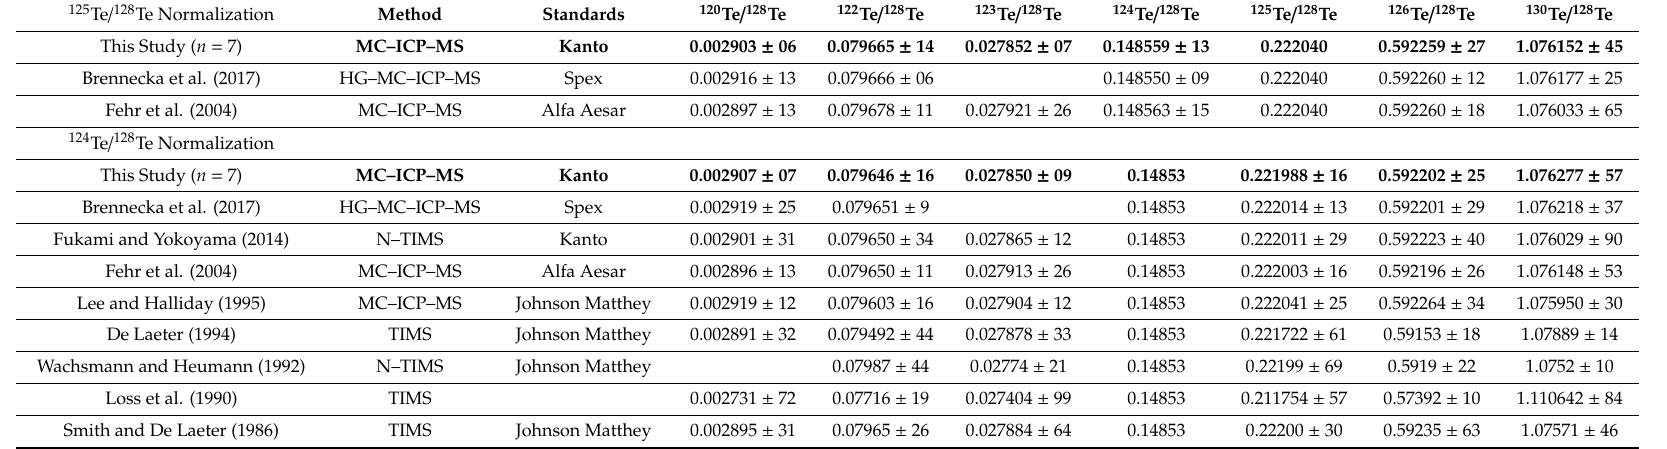
Uncertainties are expressed in 2SD (two standard